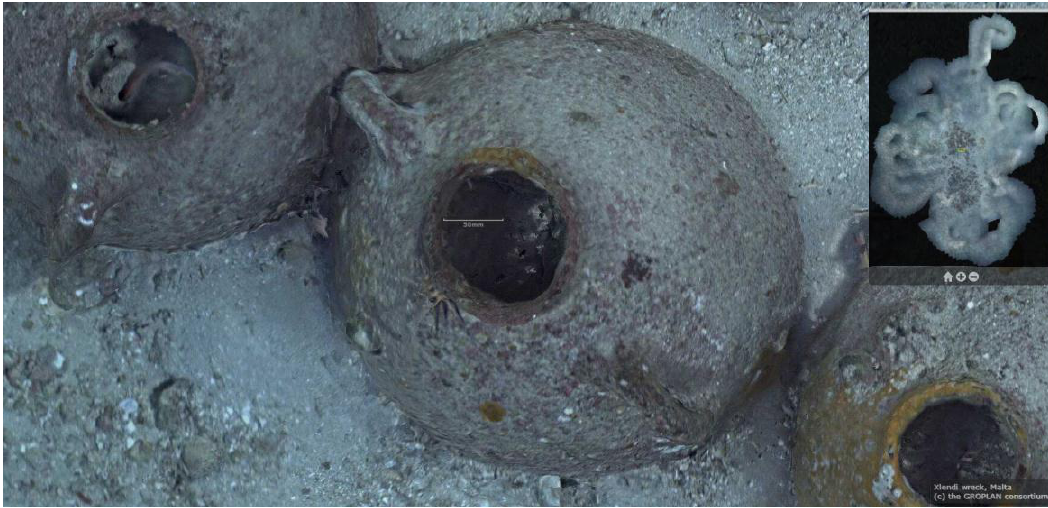
Figure 2. Very high resolution orthophoto from the project’s website (http://www.groplan.eu). A zoomed-in of the image shown in Figure 1.